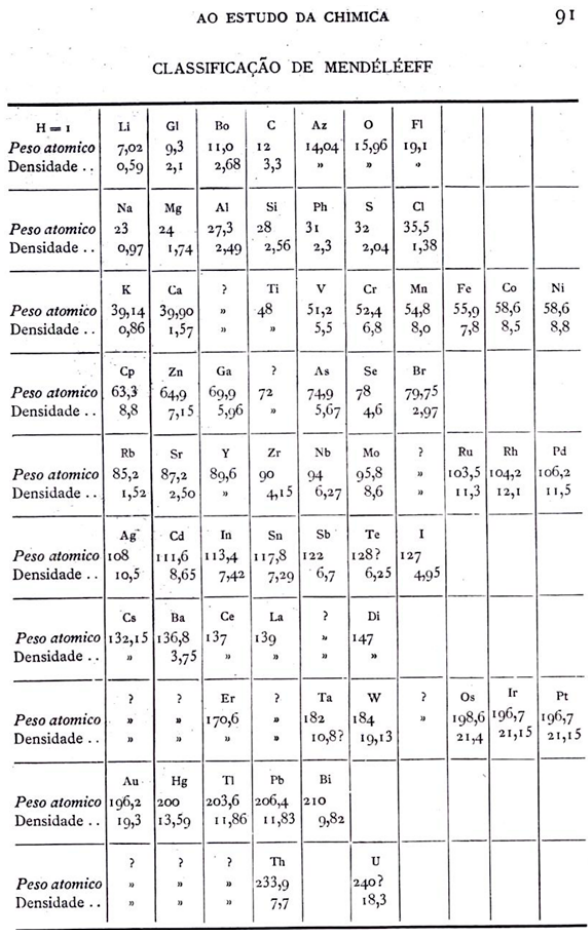
Figure 1. Classification of Mendeleev, printed in Eduardo Burnay’s book (ref. 26, p.